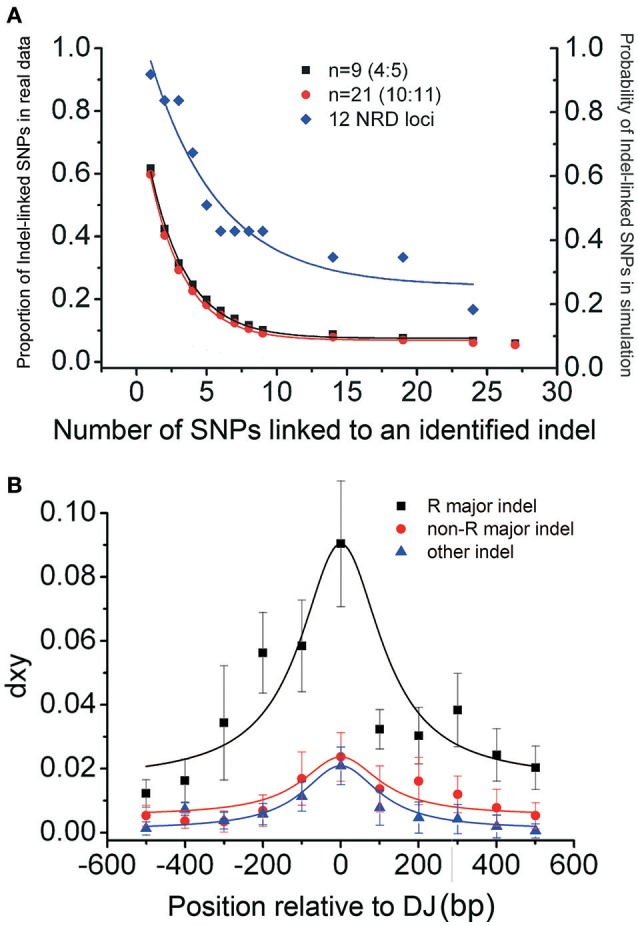
Distribution of nucleotide substitutions around indels in the RGD and NRD loci shows a close association between indels and nucleotide dimorphisms. (A) The probability of a 600-bp locus containing certain numbers of SNPs linked to a previously identified indel expected by the neutral model (the bottom two lines) and proportion of linked SNPs observed in the NRD1–12 loci (the top line). Black (or red) lines are from the simulations assuming that there are nine (or 21) accessions, and the indel frequency is 4:5 (or 10:11). The observed dimorphic substitutions in the 12 NRD junction regions (blue line) are overall significantly higher than the simulated results (Supplementary Figure S2 legend for more details). (B) Relationship between dxy and distance from major indels at five RGD loci (black-filled rectangle), at NRD1–12 (black-filled circle), and from the other 25 indels at the loci above (blue-filled triangle). Selected indels are positioned at 0. The standard error of mean (SEM) was denoted as error bar for each point.